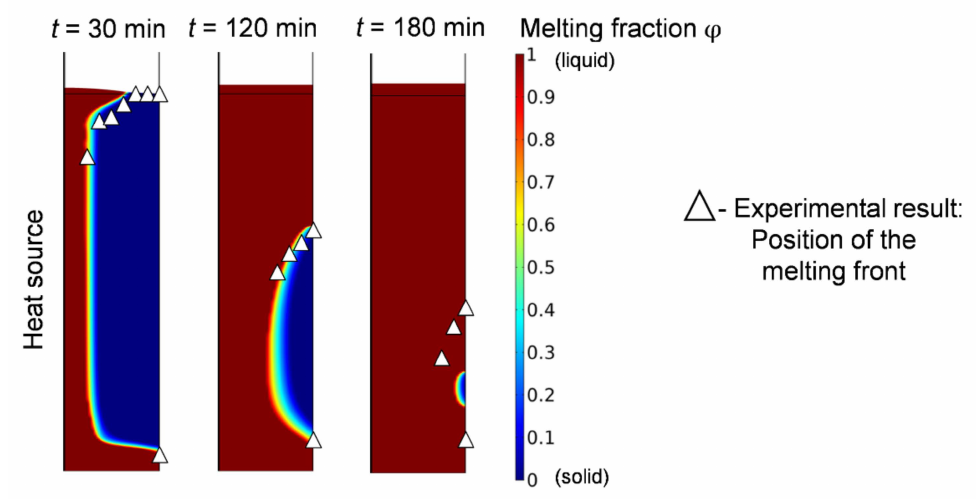
Figure 6. Comparison of the experimental results (triangles) and numerical results of the enhanced model (melting fraction ϕ ).